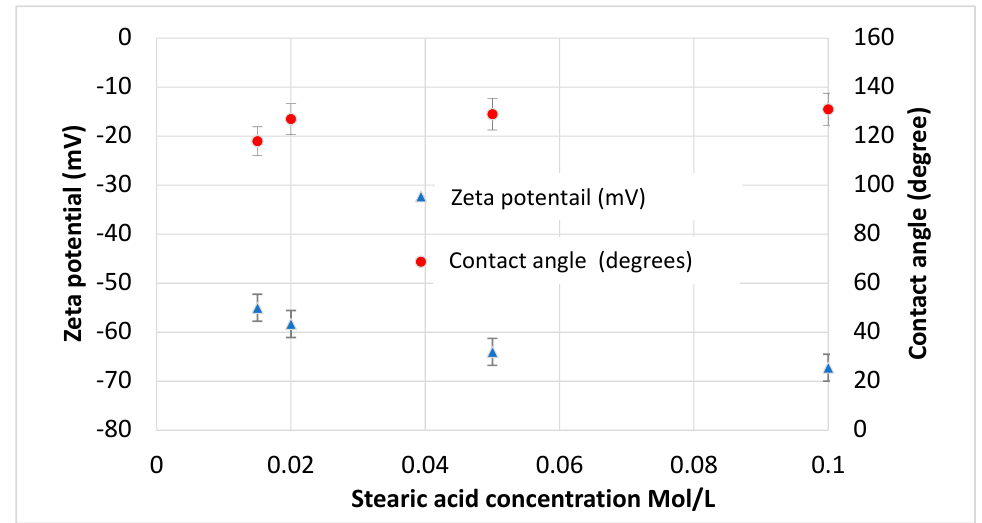
Figure 8. Contact angle and zeta potential as a function of the concentration of stearic acid in n -decane in the presence of water for the new set of data used as validation tests for the proposed equations.